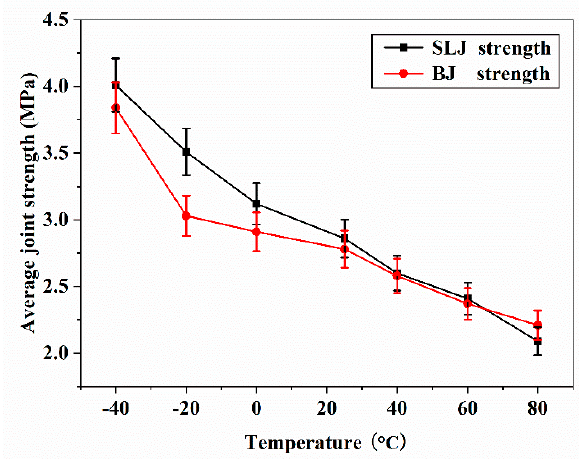
Figure 10. Average SLJ and BJ strength as a function of temperature.